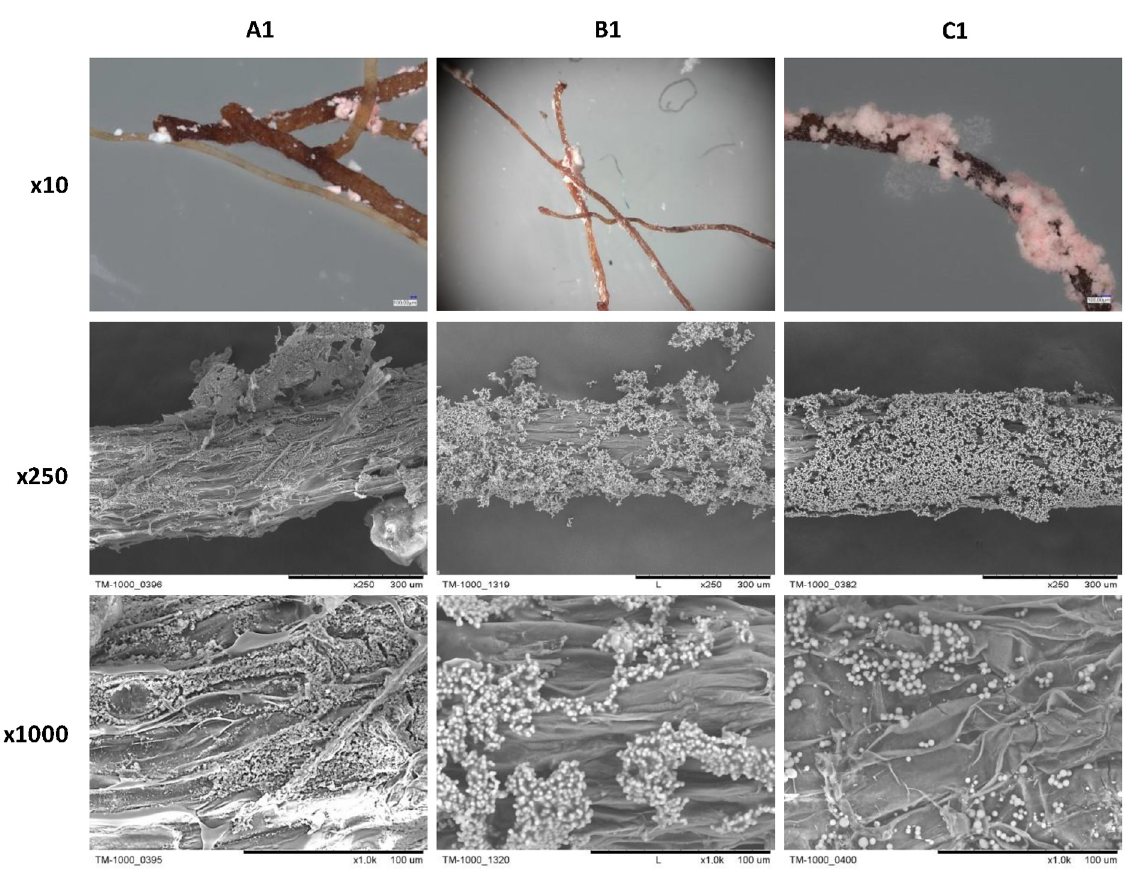
Figure 11. The optical microscope images (×10 magnification) and SEM micrographs (x250 and x1000 magnifications) of hairy roots cultured in samples A1, B1, and C1.